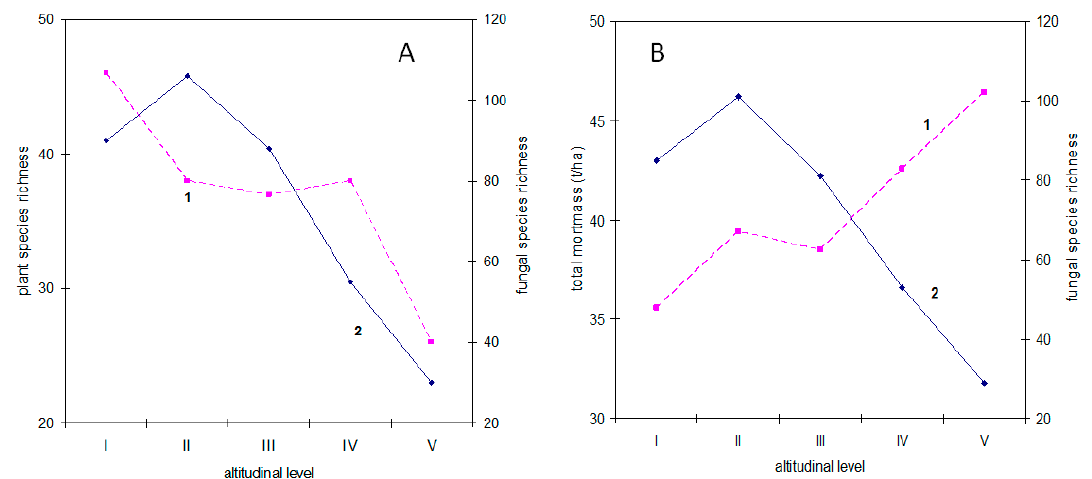
Figure 6. Vascular plant richness, fungal richness and total mortmass at different altitudinal gradients I–V. ( A ) 1—Vascular plant species richness; 2—Fungal species richness; ( B ) 1—Total mortmass; 2—Species richness of saprobic aphyllophoroid fungi.